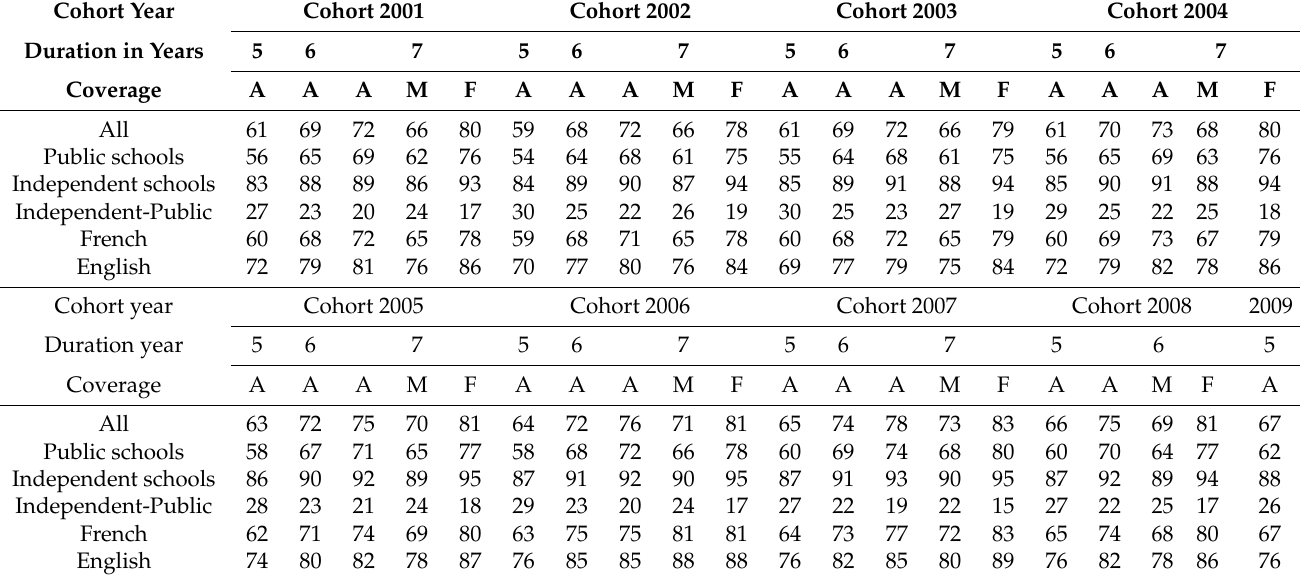
Table A5. High school graduation rate by cohort, number of years since entrance in high school, sex, schooling system, and language of instruction, cohort 2001 to cohort 2009, Qu é